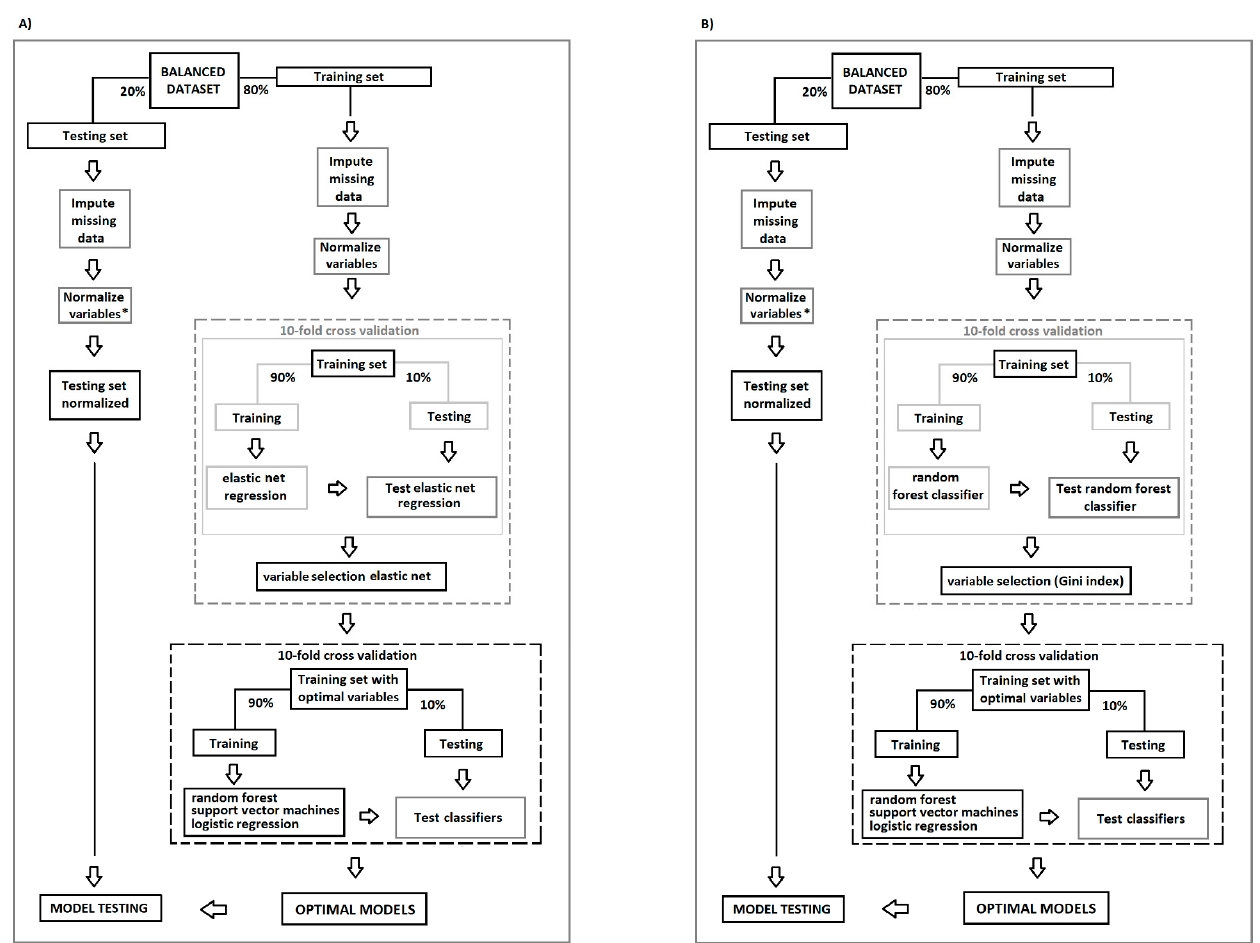
Figure 1. Data analysis process, variable selection strategies: ( A ) by elastic net regression and ( B ) Gini index, and cross- validation performance to obtain the optimal models for cancer prediction. * Variables in the testing set were standardized using the mean and standard deviations from the training set.